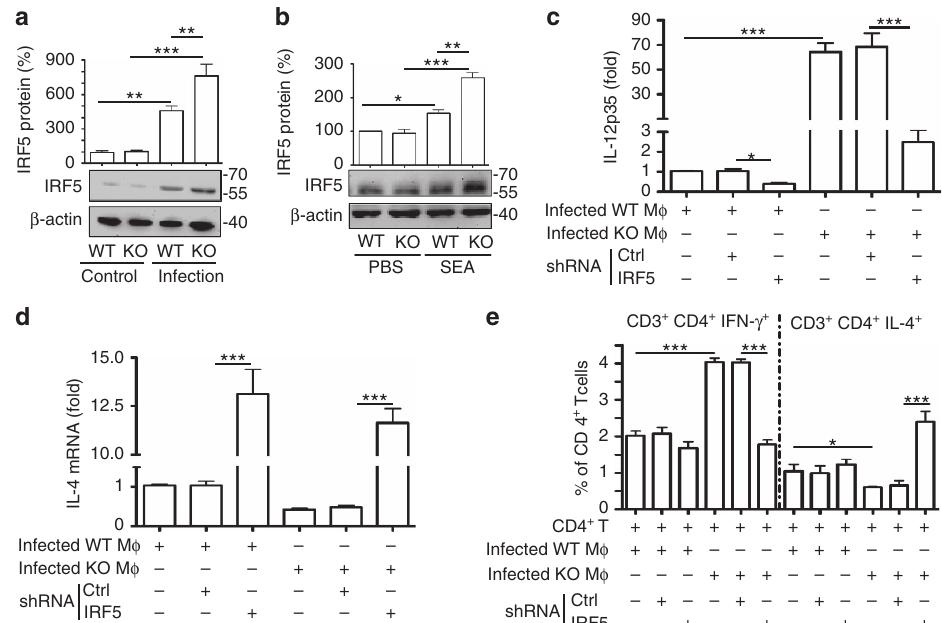
Figure 5 | SR-A-promoted M2 polarization is associated with decreased IRF5 amounts. ( a ) Immunoblot analysis of IRF5 in total protein extracts from peritoneal macrophages from WTor SR-A-deficient mice infected with or without S. japonicum . Data are expressed as the mean ± s.d. from each group, and are representative of one typical experiment out of three, *** P o 0.001, ** P o 0.01 (ANOVA/LSD). ( b ) IRF5 protein levels in peritoneal macrophages from WTor SR-A-deficient mice after 48h of stimulation with SEA. ( c – e ) Peritoneal macrophages from S. japonicum -infected WTor SR-A-deficient mice were transfected with sh-IRF5 or ctrl-shRNA in the presence of SEA. RT–PCR analysed the mRNA level of IL-12p35 ( c ) or IL-4 ( d ). ( e ) After transfection, peritoneal macrophages were co-cultured with CD4 þ Tcells from control WT mice stimulated with SEA, and Th1 and Th2 cells were analysed by FACS. Data are expressed as the mean ± s.d. of each group, and are representative of one typical experiment out of three, *** P o 0.001, ** P o 0.01, * P o 0.05